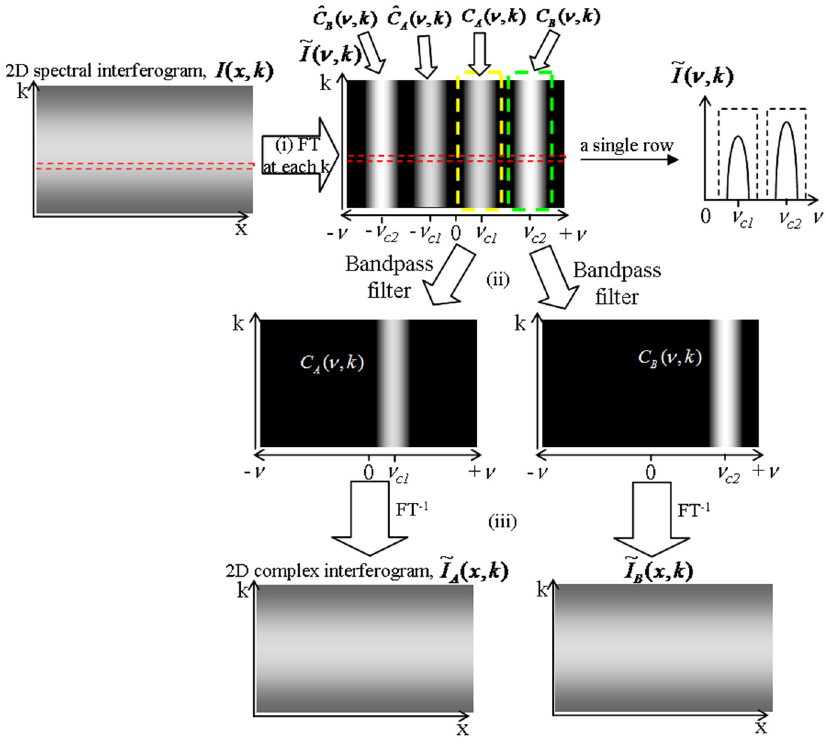
Figure 2. Data processing flowchart of the spatial frequency domain multiplexing SDOCT system. FT: Fourier Transform